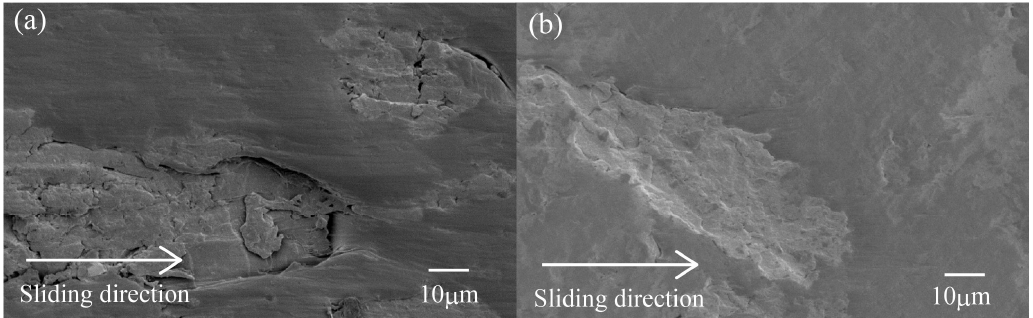
Figure 8. SEM photographs of the worn surface after sliding wear tests of various surface-treated HF/PA1010 biomass composites: ( a ) HF (Magnification of Figure 7b) and ( b ) HF-S3-20 (Magnification of Figure 7e).